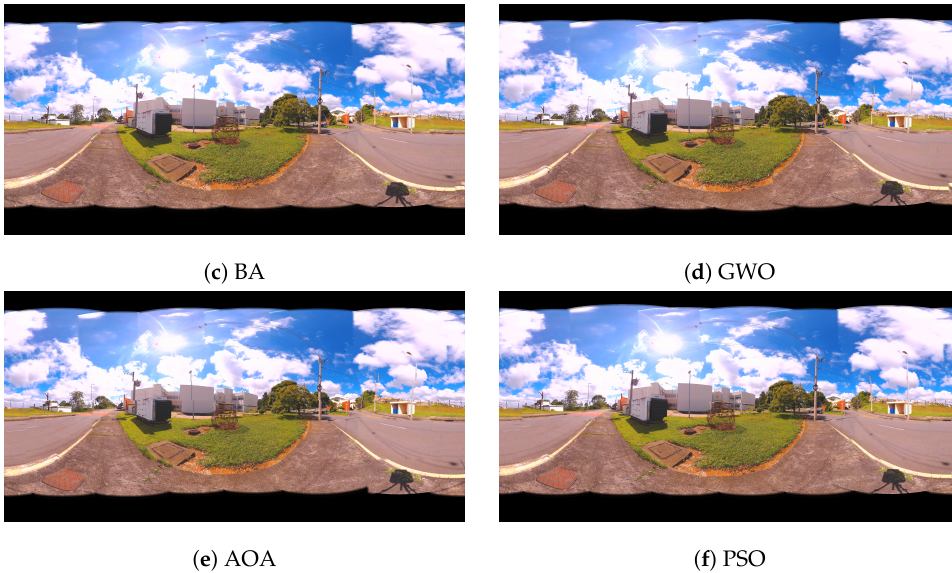
Figure 9. 360 Panoramic Images Resulting from the Proposed Metaheuristics for Case Study I: ( a ) Levenberg–Marquardt (LM), ( b ) Salp Swarm Algorithm (SSA), ( c ) Bat Algorithm (BA), ( d ) Grey Wolf Optimizer (GWO), ( e ) Arithmetic Optimization Algorithm (AOA) and ( f ) Particle Swarm Optimization (PSO).